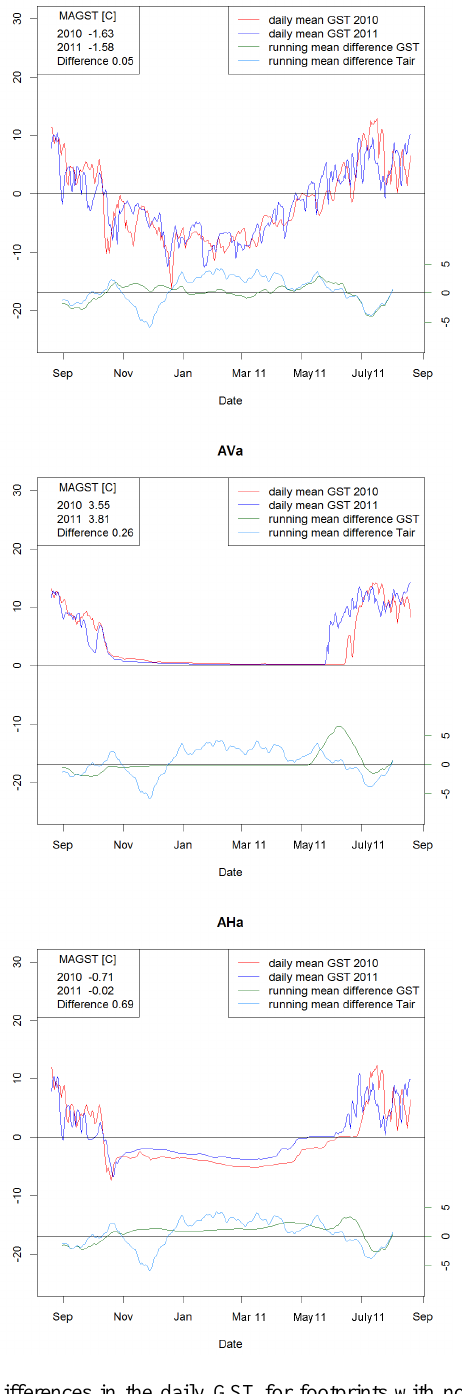
Fig. 8. Differences in the daily GST for footprints with no insu- lating snow cover (AOa), an insulating snow cover but no frozen ground (Ava), and an insulating snow cover with frozen ground (AHa). Based on air temperature measurements from Piz Corvatsch, the running mean of the difference between the air temperature of the two years is